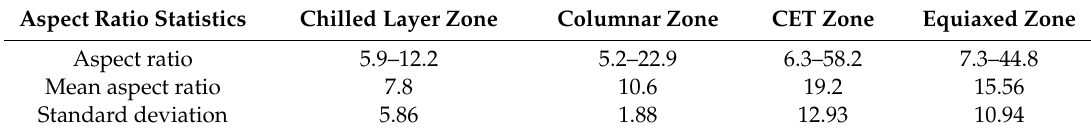
Table 4. Aspect ratio of CaS inclusions in di ff erent regions of continuous casting (CC)